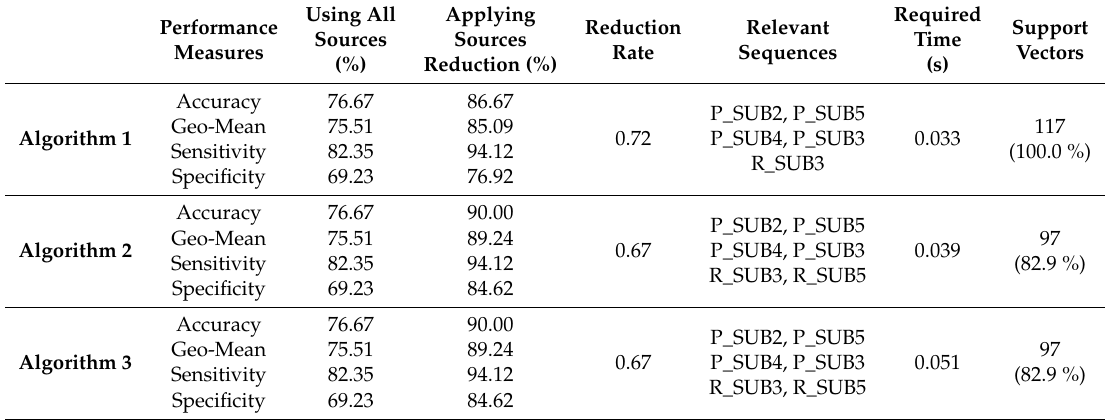
Table 7. Results of selection of MRI sequences with perceptual and radiomic features with (cid:96) 1